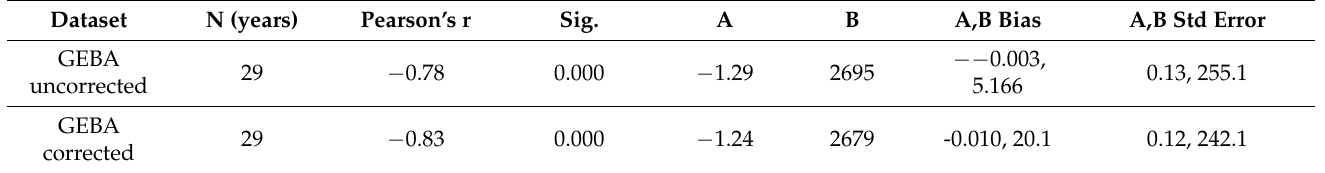
Table 6. Linear regression of annual GEBA data with bootstrapping (N = 1000).